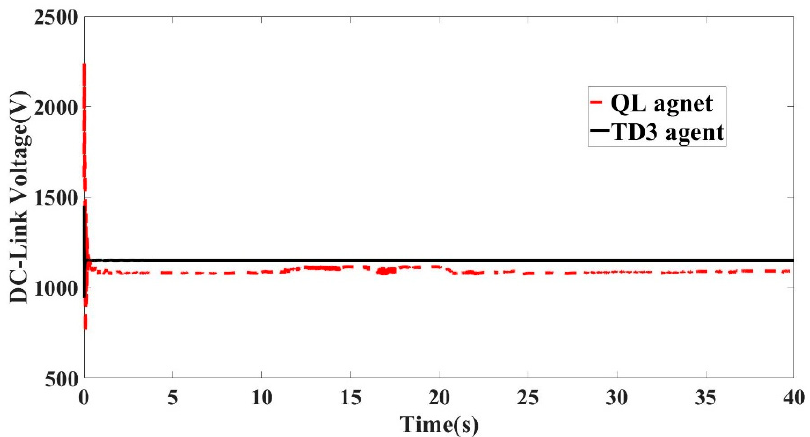
Figure 32 . DC ‐ link voltage with TD3 agent vs. Q ‐ learning.